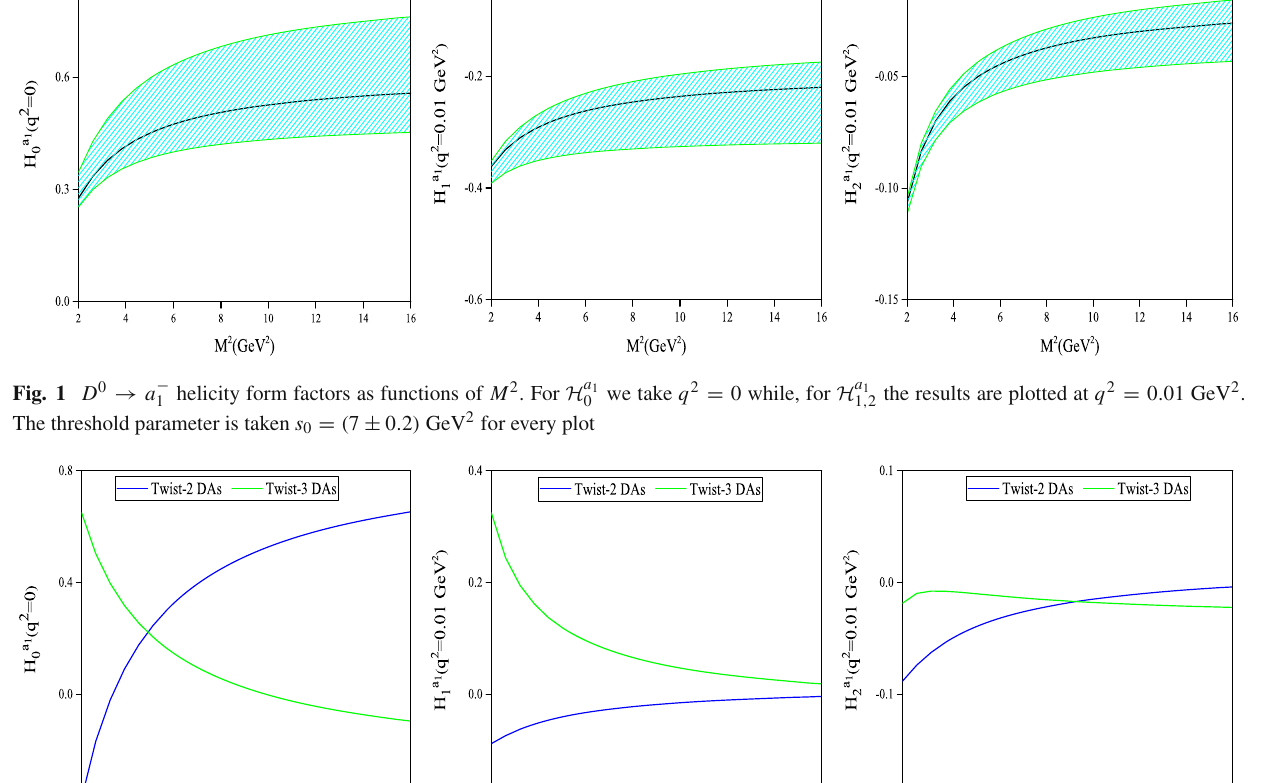
we take q 2 = 0 while, for H a 1 0